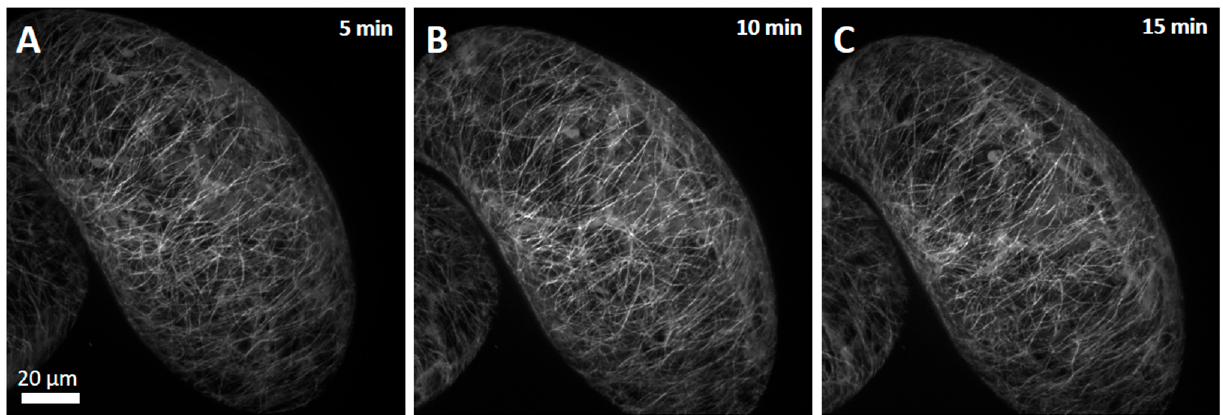
Figure 7. E ff ect of essential oil from M. longifolia on microtubules in tobacco BY-2 cells visualised by the marker NtTuA3-GFP and spinning disc confocal microscopy. Time course of a cell after 10 min ( A ), 20 min ( B ), and 30 min ( C ) of treatment with essential oil of M. longifolia (0.1% v / v ).